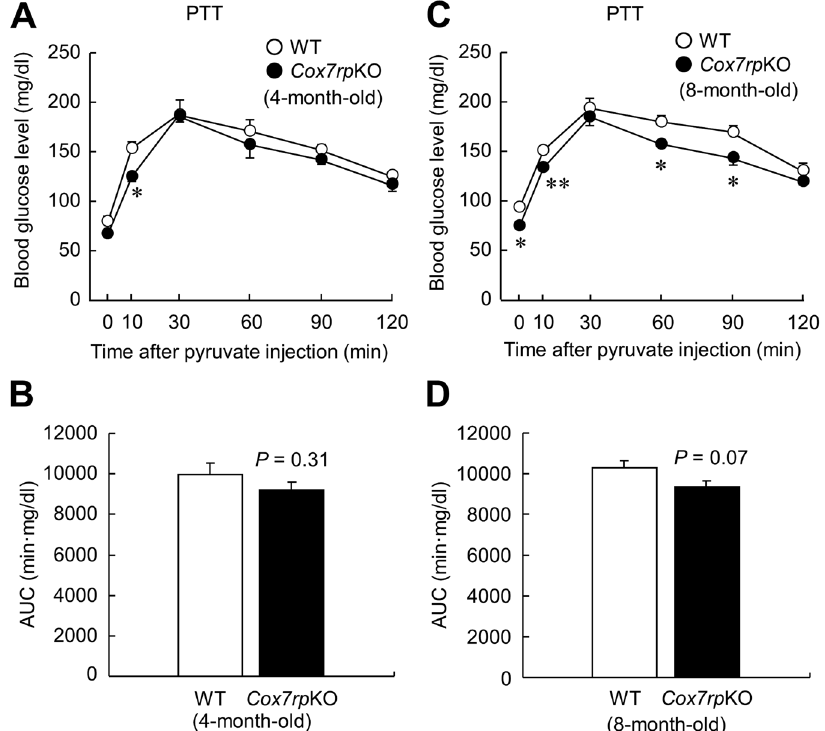
Figure 5. Lower blood glucose levels in 4- and 8-month-old Cox7rp KO mice versus WT mice during pyruvate tolerance test (PTT). Cox7rp KO and WT mice at 4-month-old and 8-month-old were fasted for 16 h, then injected intraperitoneally with pyruvate (2 g/kg body weight). Blood glucose level ( A ) and the AUC ( B ) in PTT at 4-month-old. Blood glucose level ( C ) and the AUC ( D ) in PTT at 8-month-old. Data are presented as means ± SEM ( n = 4). * P < 0.05, ** P < 0.01, using Student’s t